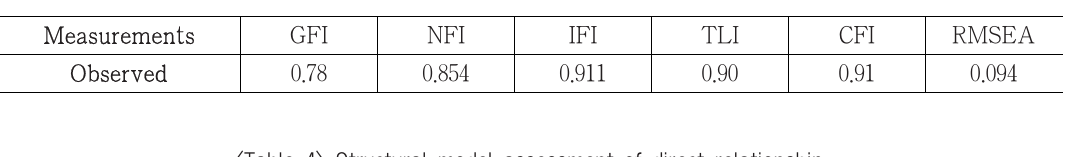
<Table 3> Goodness of fit of the final research model